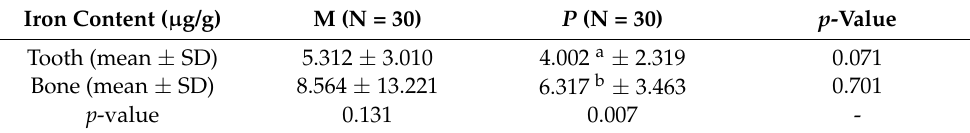
Table 18. Iron content in tested samples taken from patients differing in place of residence.